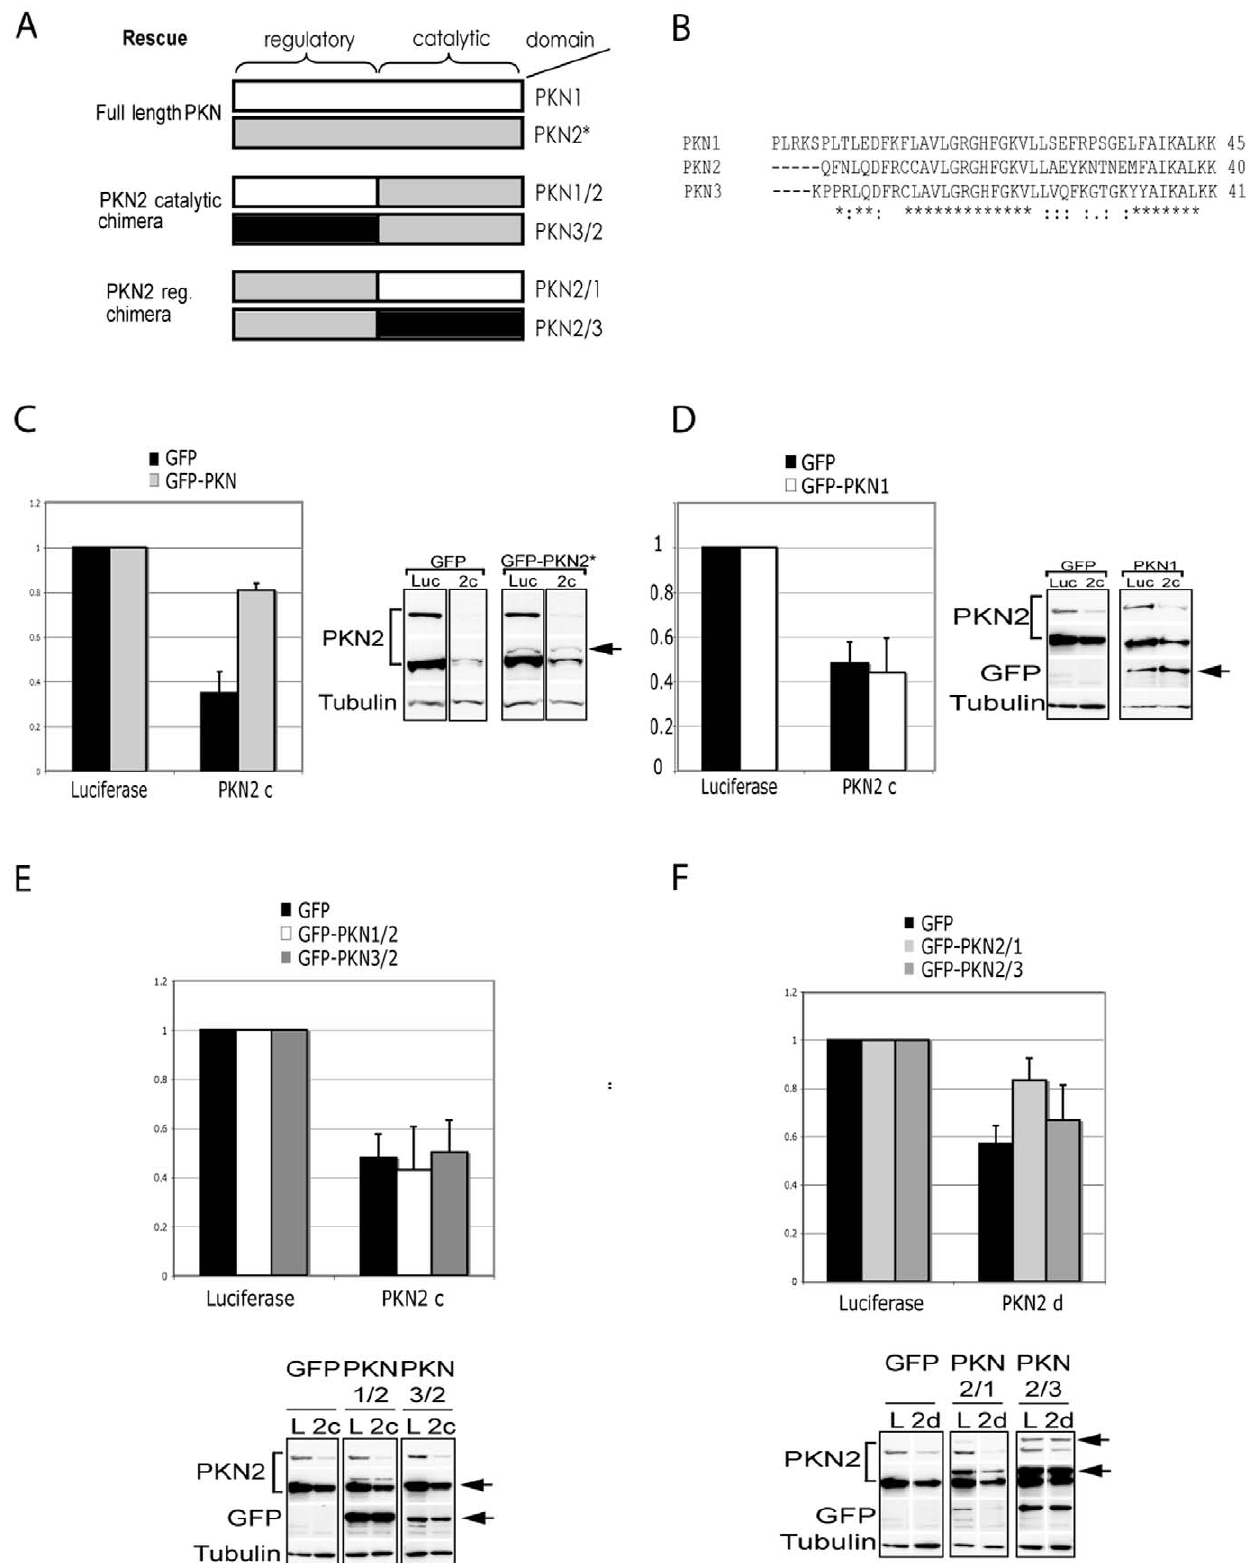
Figure 4. Overexpression of full length PKN2 or a PKN2/1 chimera can rescue migration defects of 5637 cells with PKN2 knock down. A. Scheme of siRNA resistant rescue constructs. B. Comparison of the initial 40 amino acids of the PKNs catalytic domains used for cloning combinations of PKN regulatory and catalytic domain chimeric constructs. C. 5637 cells were stably transfected with GFP or GFP-PKN2* resistant